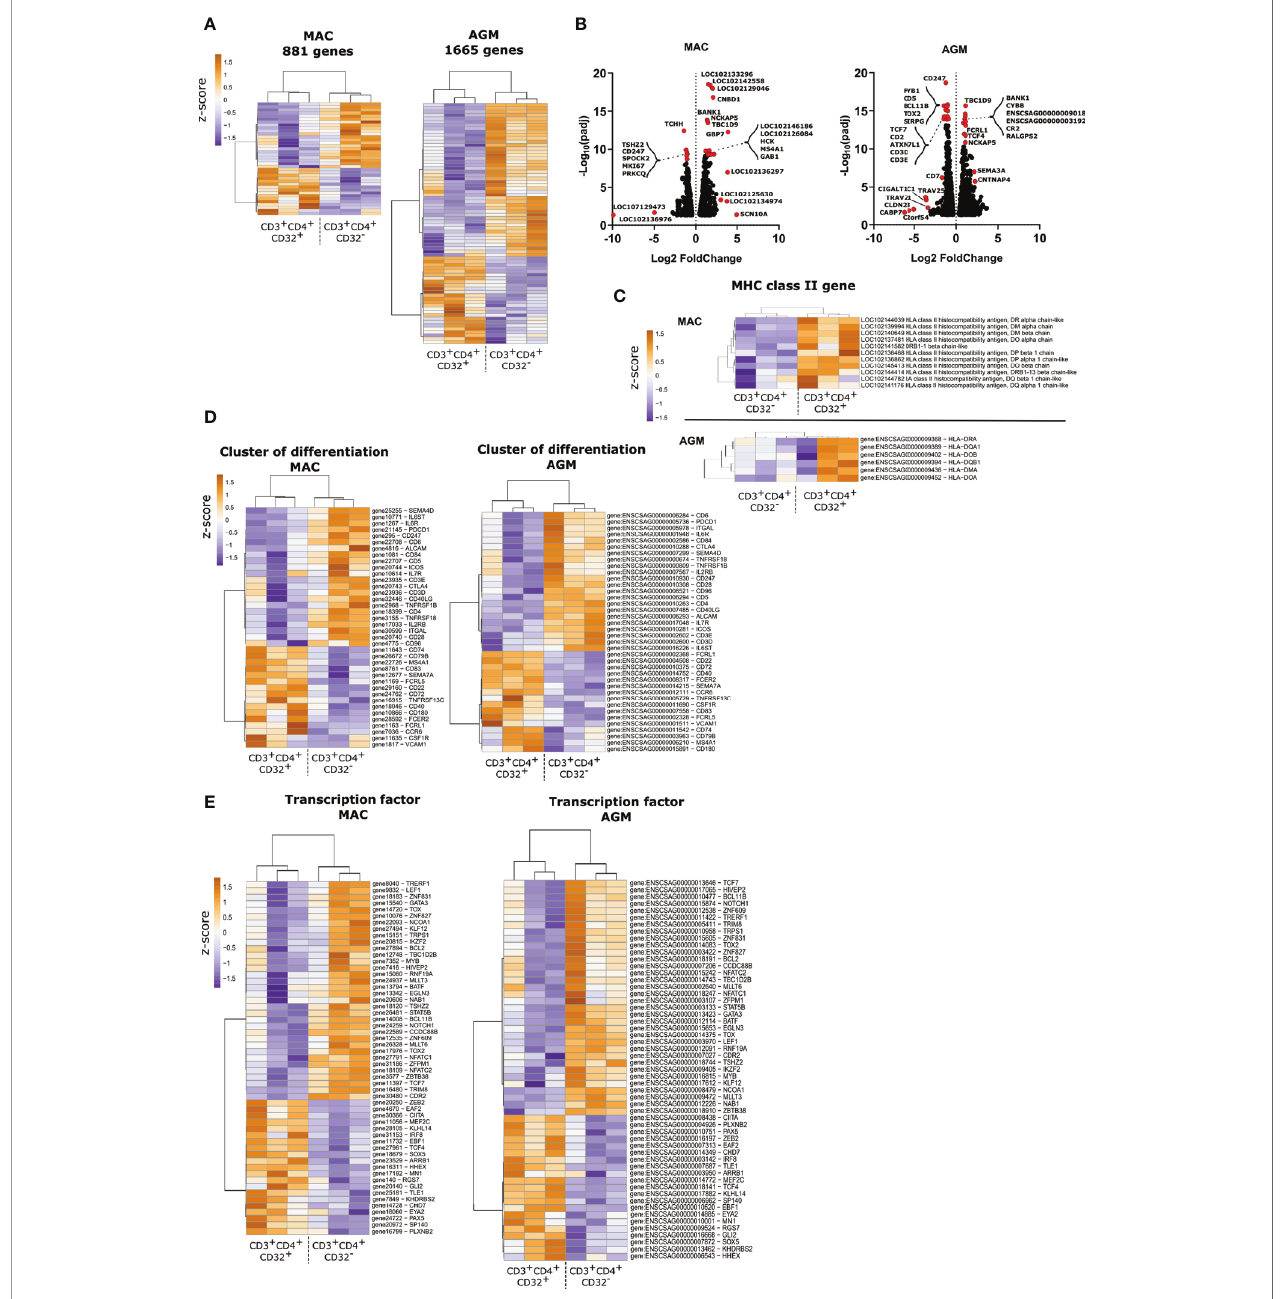
FIGURE 4 | Genome-wide transcriptome analysis of CD4+ T cell subsets according to CD32 expression from spleen during pathogenic and non-pathogenic SIV infection. (A) Heatmaps of transcript signatures in CD32+ and CD32 - CD4+ splenic T cells from chronically SIV-infected MAC and AGM. (B) Volcano plots of gene regulation between CD32+ and CD32 - CD4+ T cells. Red dots represent highly differentially regulated genes. Many of them are associated with the B cell lineage. (C, E) Heatmaps showing (C) MHC-II molecules (D) cluster of differentiation transcripts and (E) transcription factors mRNA levels on CD4+ T cell subsets according to CD32+ expression. In each panel, subsets were organized based on the overall similarity in gene expression patterns by an unsupervised hierarchical clustering algorithm of variable genes. A dendrogram, in which the pattern of branch length re fl ects the comparative difference in gene expression pro fi les between samples is shown. A p-value adjustment was performed to account for multiple comparisons and control the false positive rate to a chosen level. Transcriptome similarity between clusters of spleen sample was evaluated by the Euclidean distance and visualized via heatmap. Each row represents a variable gene among clusters, and each column represents one subset per monkey. Deep sequencing results were deposited in the Gene Expression Omnibus database; the accession number is